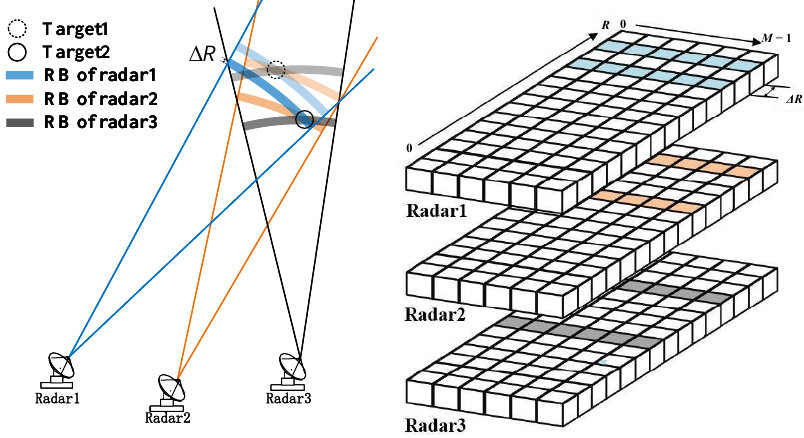
Figure 1. Relationship between range bins and the received